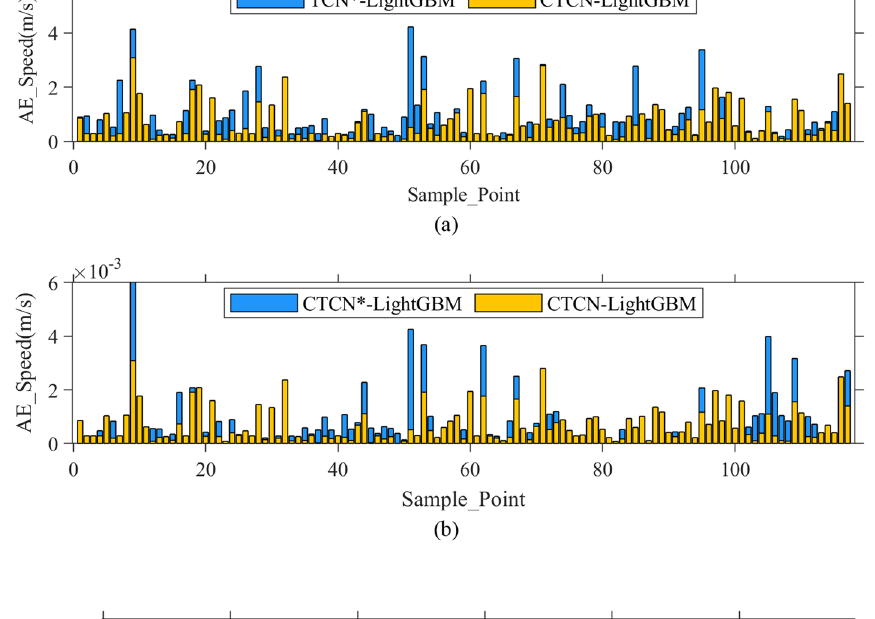
Fig. 9 Actual prediction results for chute flow